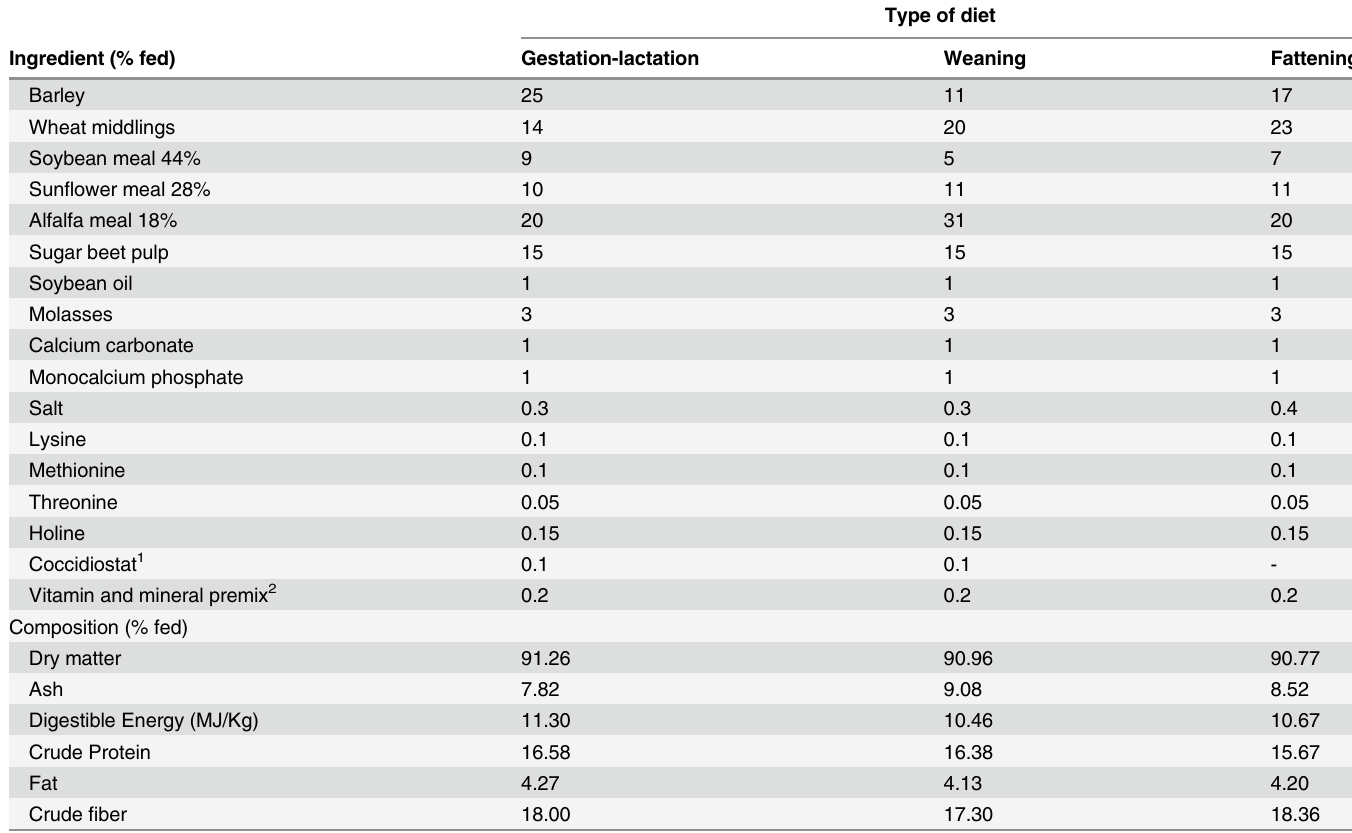
Table 1. Ingredients and calculated chemical composition of the commercial diets used in the study.